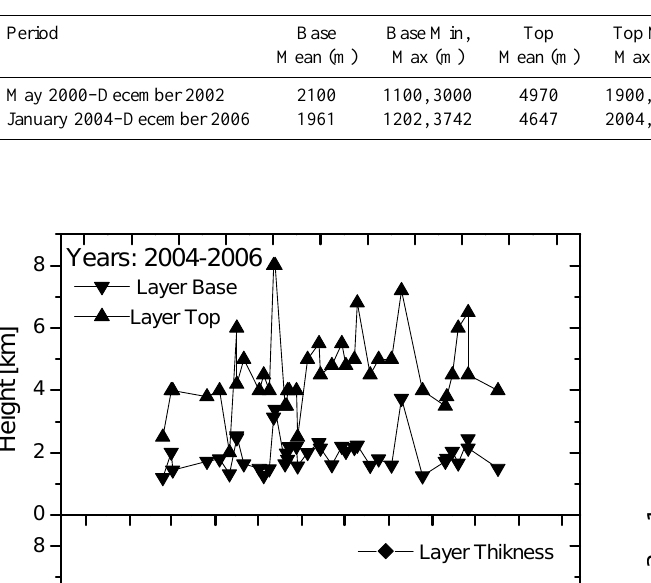
Table 1. Height distribution of the mean, minimum and maximum values of desert dust altitude range parameters (base, top, thickness and center of mass) retrieved from lidar backscatter data obtained at 532nm over Athens (January 2004–December 2006) in comparison with older data (May 2000–December 2002), as given by Papayannis et al. (2008).